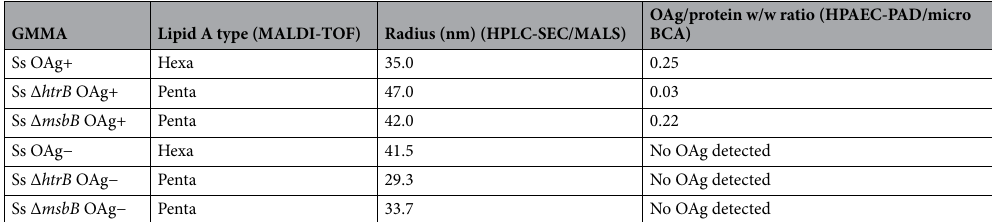
Table 2. Analytical characterization of the antigens. The table summarizes GMMA characterization in terms of lipid A structure (MALDI-TOF), size (HPLC-SEC/MALS) and OAg to protein (w/w) ratio (HPAEC-PAD/ micro BCA).